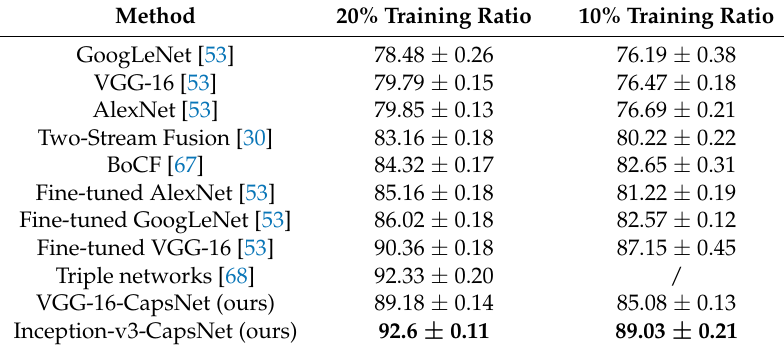
Table 3. Overall accuracy (%) and standard deviations of the proposed method and the comparison methods under the training ratios of 20% and 10% on NWPU ‐ RESISC45 dataset.